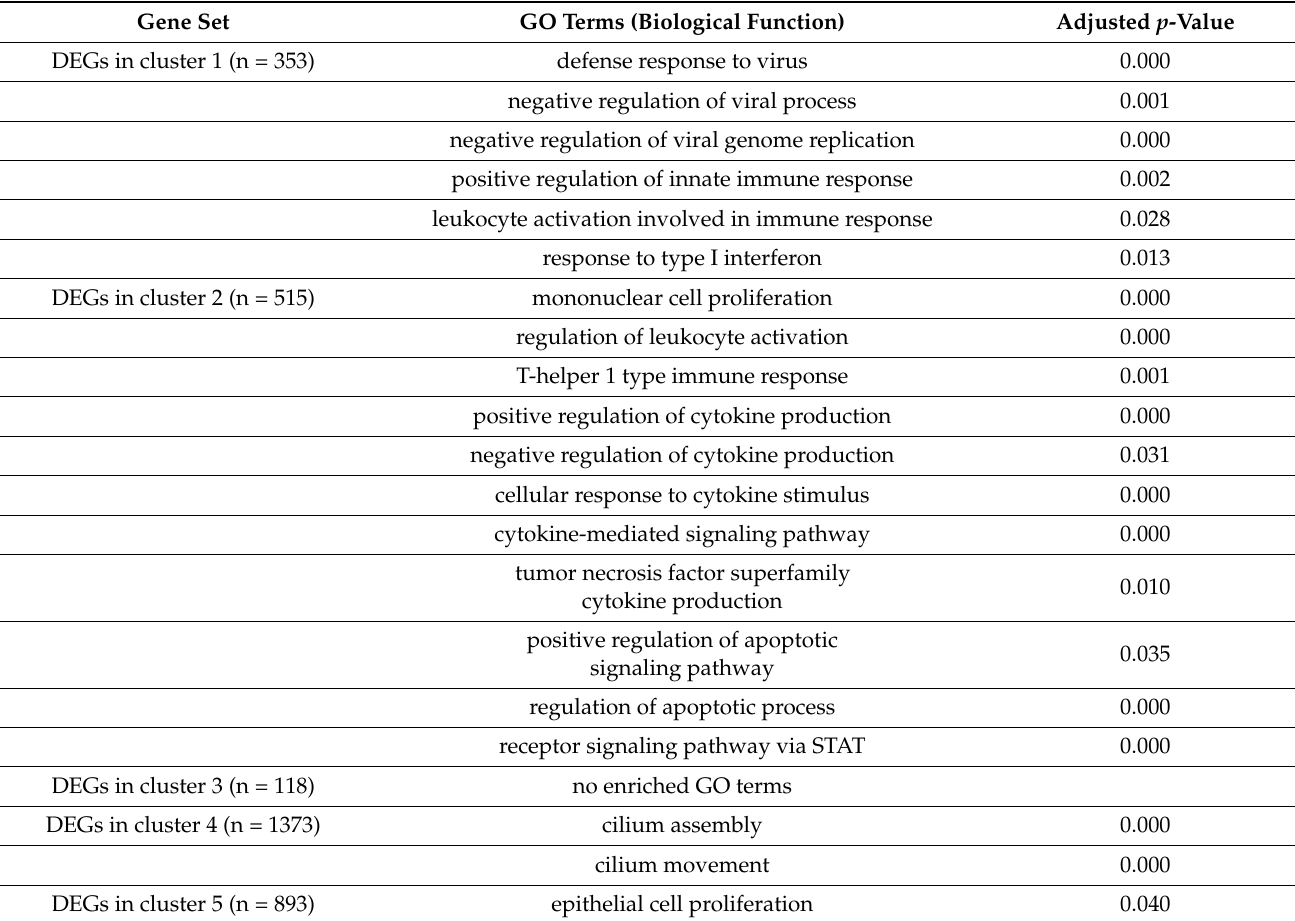
Table 1. Selected significantly enriched gene ontology (GO) terms in clusters